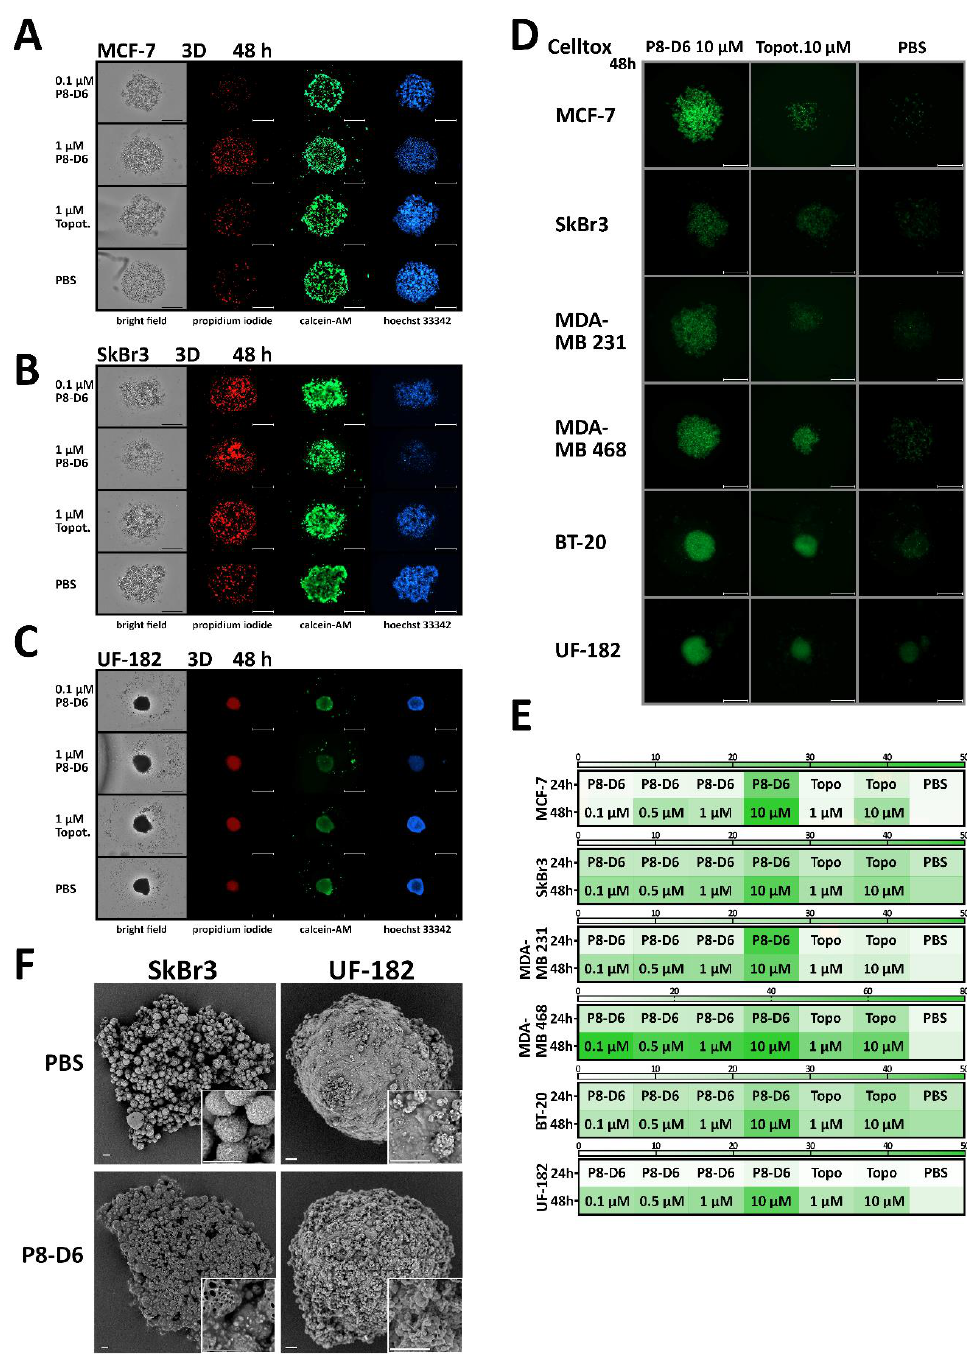
Figure 6. Cell toxicity, live-dead staining and morphological changes in BC spheroids. For 3D culture, MCF-7, SkBr3, MDA-MB231, MDA-MB468, BT-20 (cell line) and UF-182 (primary cells) cells were cultured in ULA plates for 96 h. Subsequently, spheroids were treated with P8-D6 (10 µ M, 1 µ M, 0.5 µ M, 0.1 µ M), topotecan (10 µ M, 1 µ M) and PBS for 48 h. After treatment, the spheroids were stained with propidium iodide (red), calcein-AM (green) and Hoechst 33342 (blue) and imaged using NYONE ®® Scientific. MCF-7 ( A ), SkBr3 ( B ) and UF-182 ( C ). Scale bars, 500 µ m. ( D ) During treatment, the cell toxicity was measured by fluorescence microscopy using CellTox™ Green (24 h, 48 h). Scale bars, 500 µ m. These fluorescence signals were quantified (fluorescence intensity RFU) and presented in a heat map ( E ). ( F ) The P8-D6- (1 µ M) or PBS-treated SkBr3 and UF-182 spheroids (48 h) were analyzed by scanning electron microscopy (SEM). Scale bars, 20 µ